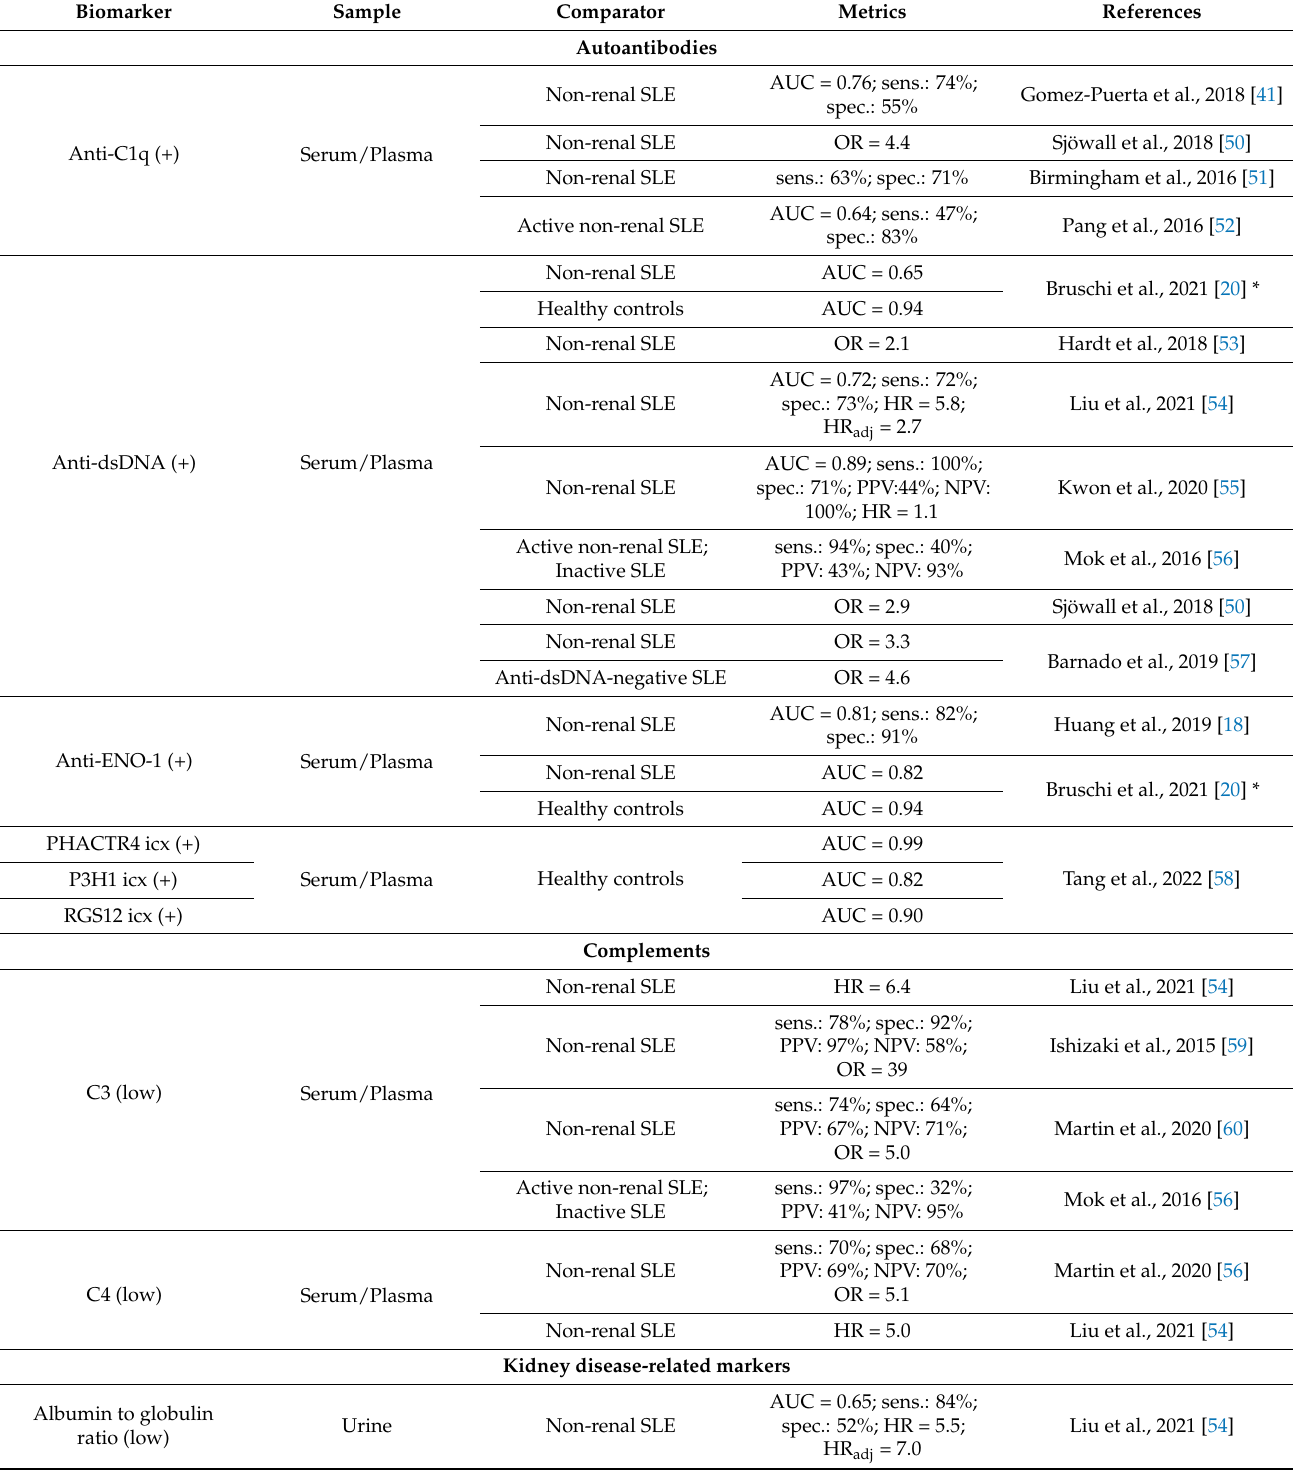
Table 1. Performances of selected diagnostic biomarkers for